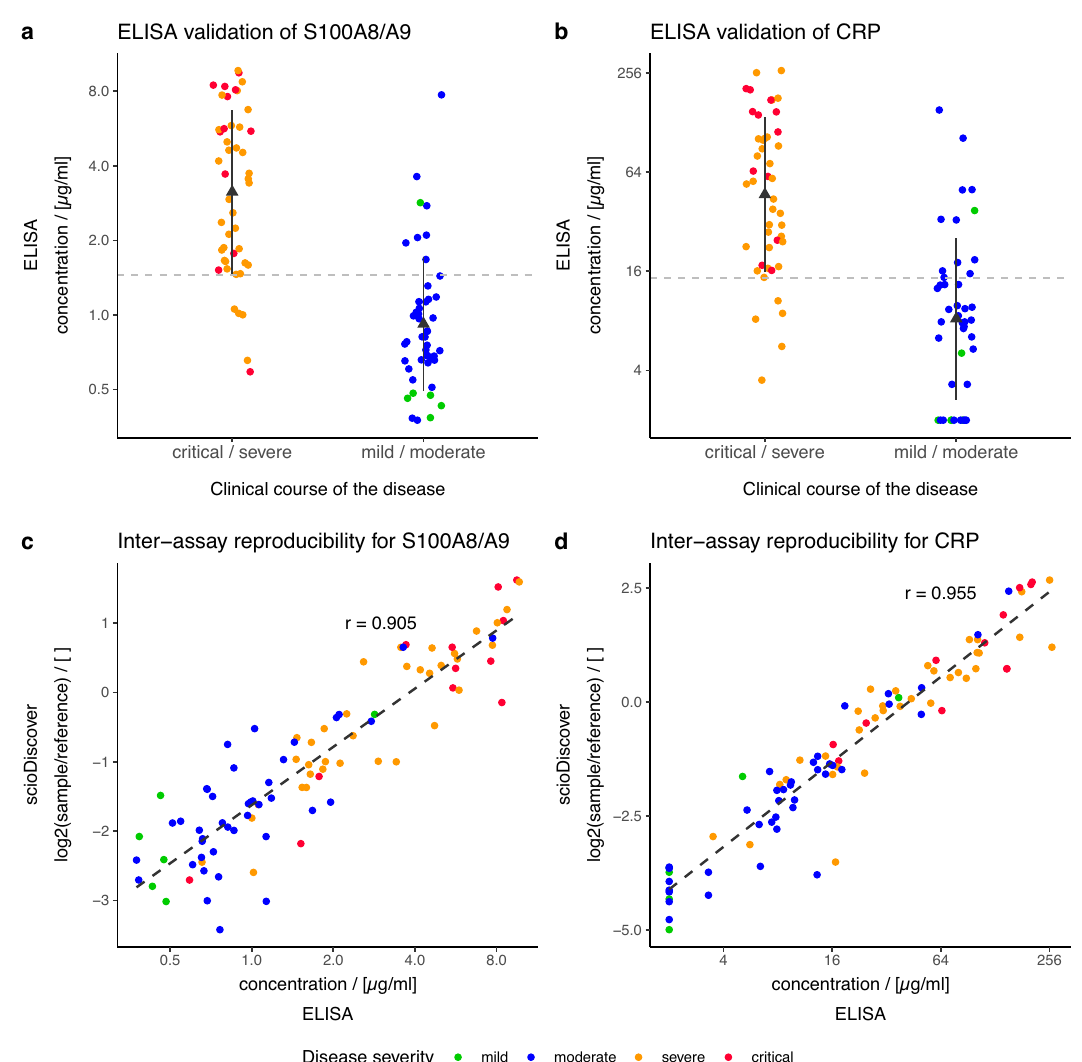
Fig. 6 Validation of microarray data. Plasma samples from 94 COVID-19 patients during the acute phase of disease (2 nd cohort) were analyzed by ELISA, to validate differentially abundant proteins between patients with either a mild or moderate (MM, n = 47) or a critical or severe (CS, n = 47) disease course. Stripcharts representing individual S100A8/A9 ( a ) and CRP ( b ) ELISA measurements. The y-axis displays the log 2 of the measured protein concentration while the x-axis is divided based on the later clinical course of disease of the patient (CS and MM). Triangles and whiskers indicate means and one standard deviation of the sample groups with critical/severe or mild/moderate course of the disease respectively. Possible cut-offs with a sensitivity of 89% are indicated by dotted grey lines. c , d Scatter plots demonstrate a high correlation between discovery antibody microarray data (y-axis) and ELISA validation (x-axis) with Pearson ’ s r >